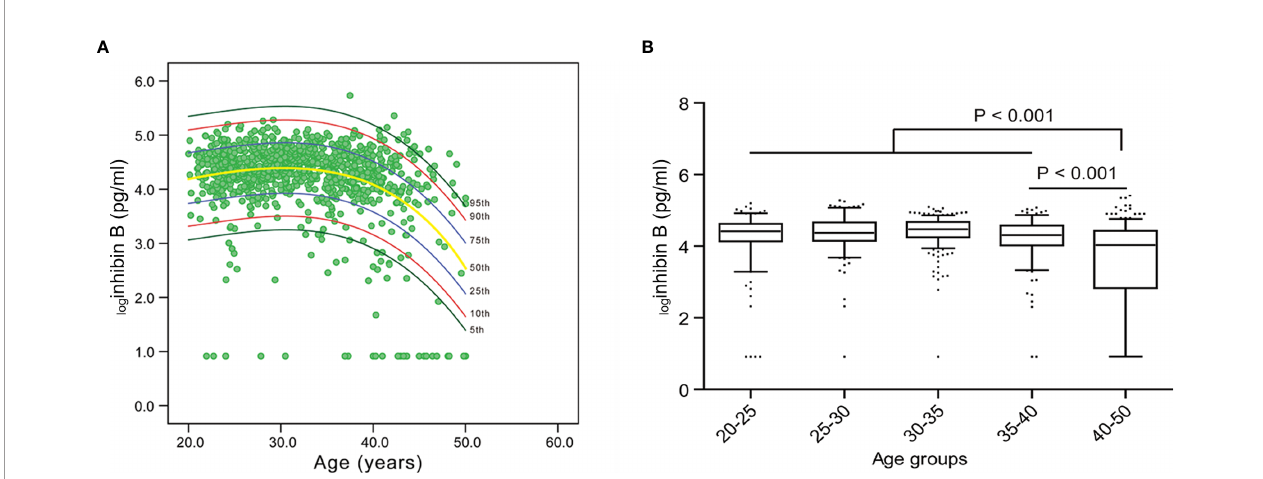
FIGURE 2 | Nomogram for inhibin B and the variation trend of inhibin B with age. (A) Inhibin B nomogram based on the cubic regression model. Each line represents the value of con fi dential interval (CI). A rapid decrease of inhibin B value was observed in women after 40 years old. (B) Median value of inhibin B in each age